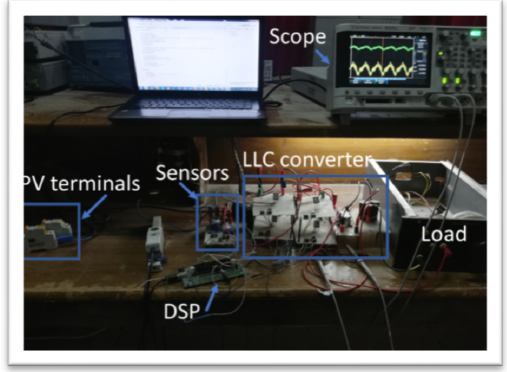
Table 1. Experimental prototype parameters.